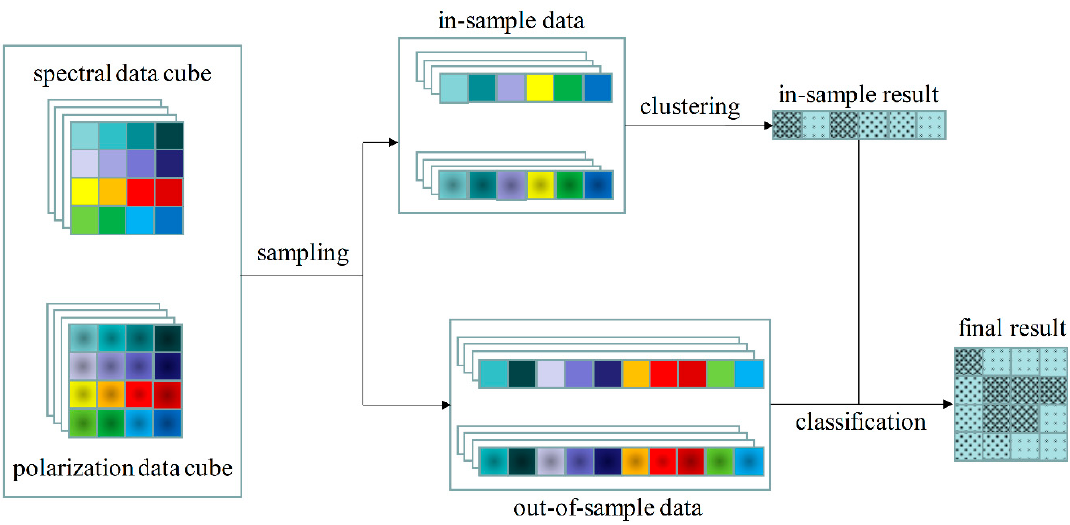
Figure 1. Architecture of proposed e ffi cient representation-based subspace clustering framework for polarized hyperspectral images.